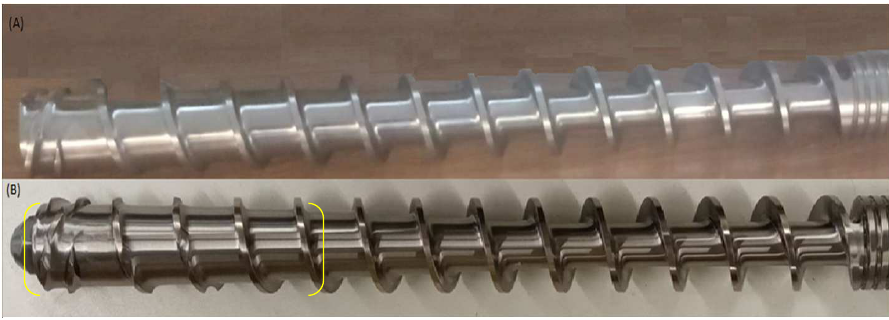
Figure 1. Part of the plasticizing system: ( A ) standard screw; ( B ) prototype (modified) screw.